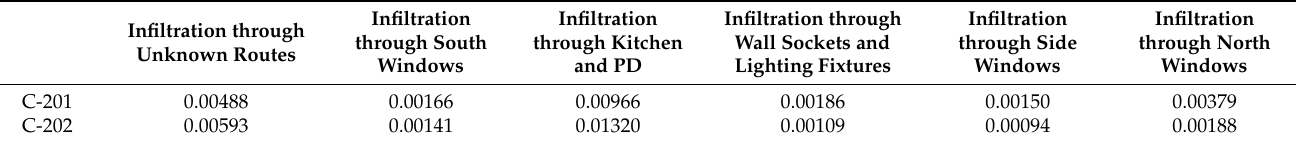
Figure 6. Analysis method for estimating the flow coefficients and pressure exponents. Table 2. Infiltration coefficient calculation result from blower door test(kg/s).